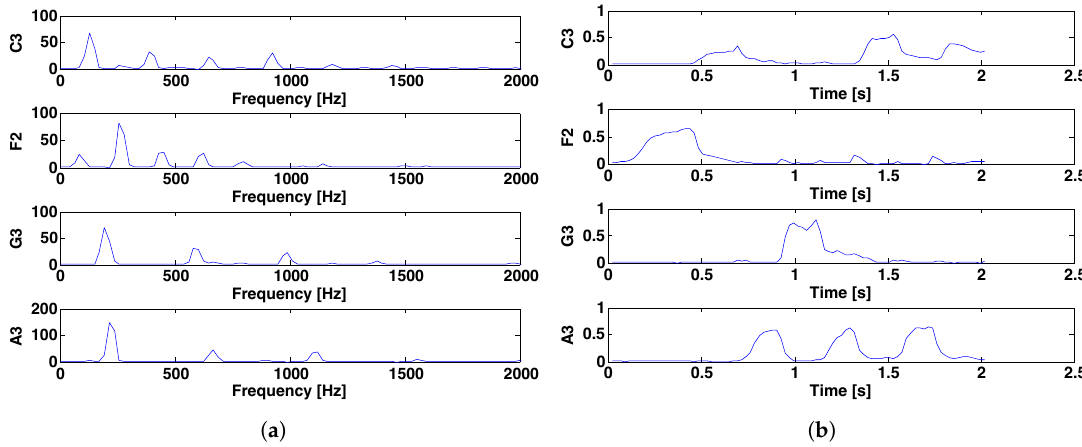
Figure 2. Example of nonnegative matrix factorization (NMF) analysis results in terms of ( a ) the column vectors of W and ( b ) the row vectors of H